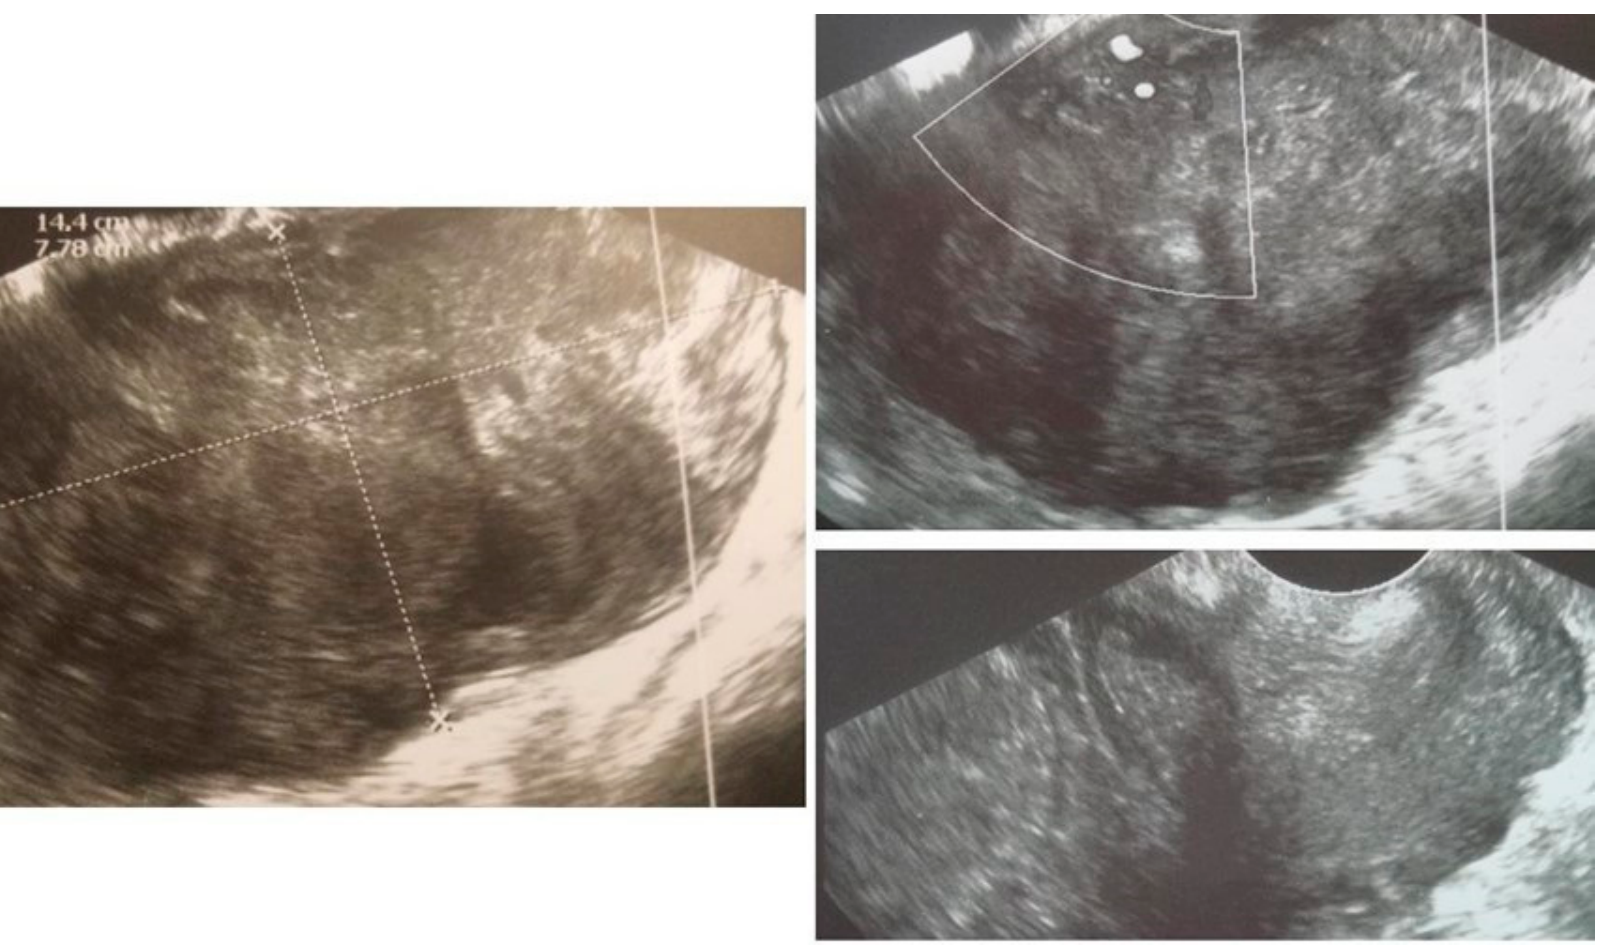
Figure A2. Transvaginal ultrasonogram of the uterine lesion—sarcoma suspicion, uterine corpus not identified, uterine cervix normal (right lower figure). Histology: LMS.